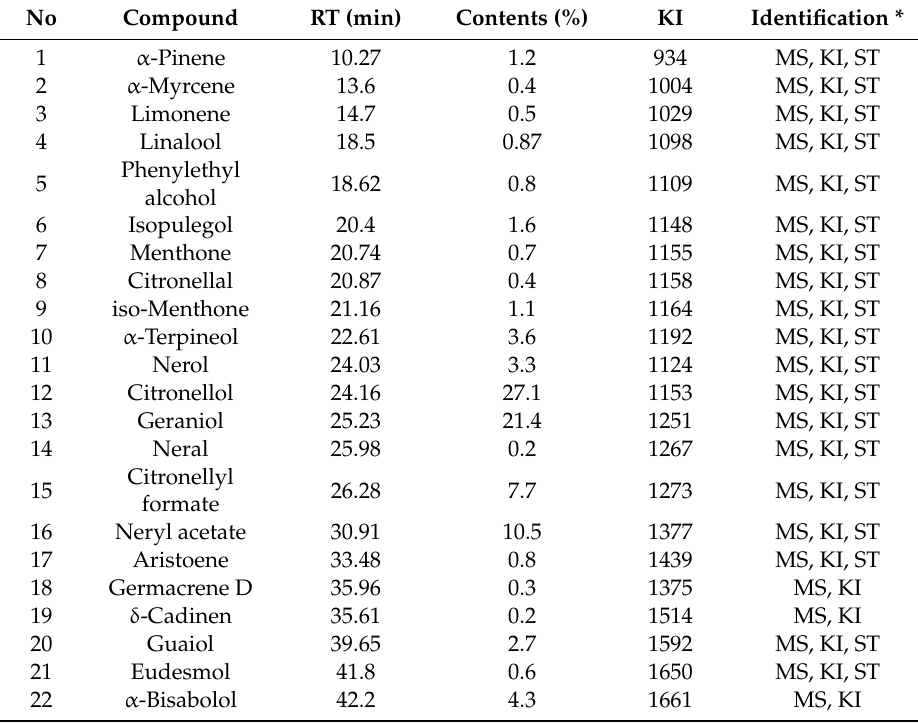
Table 2. The main components and their relative contents (%) of geranium oil.